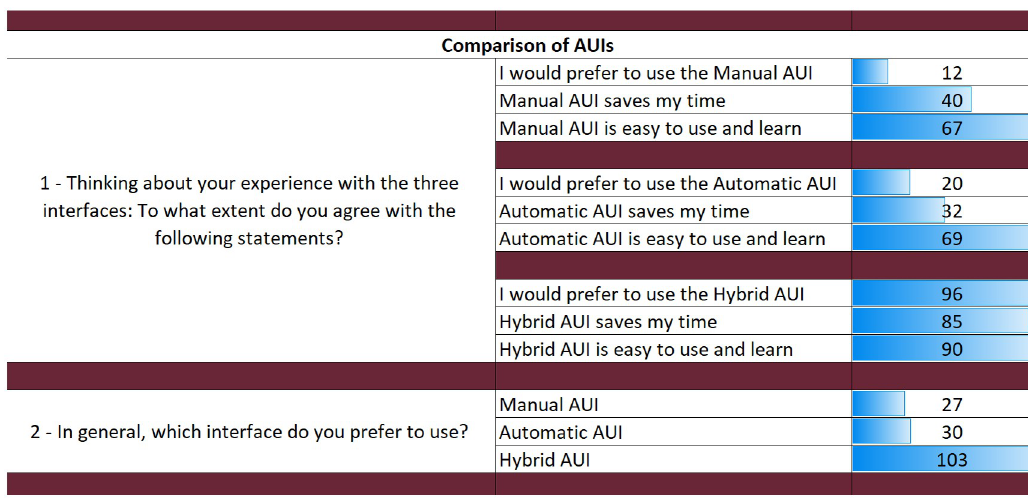
Fig 21. Questionnaire results for the comparison of three AUIs.